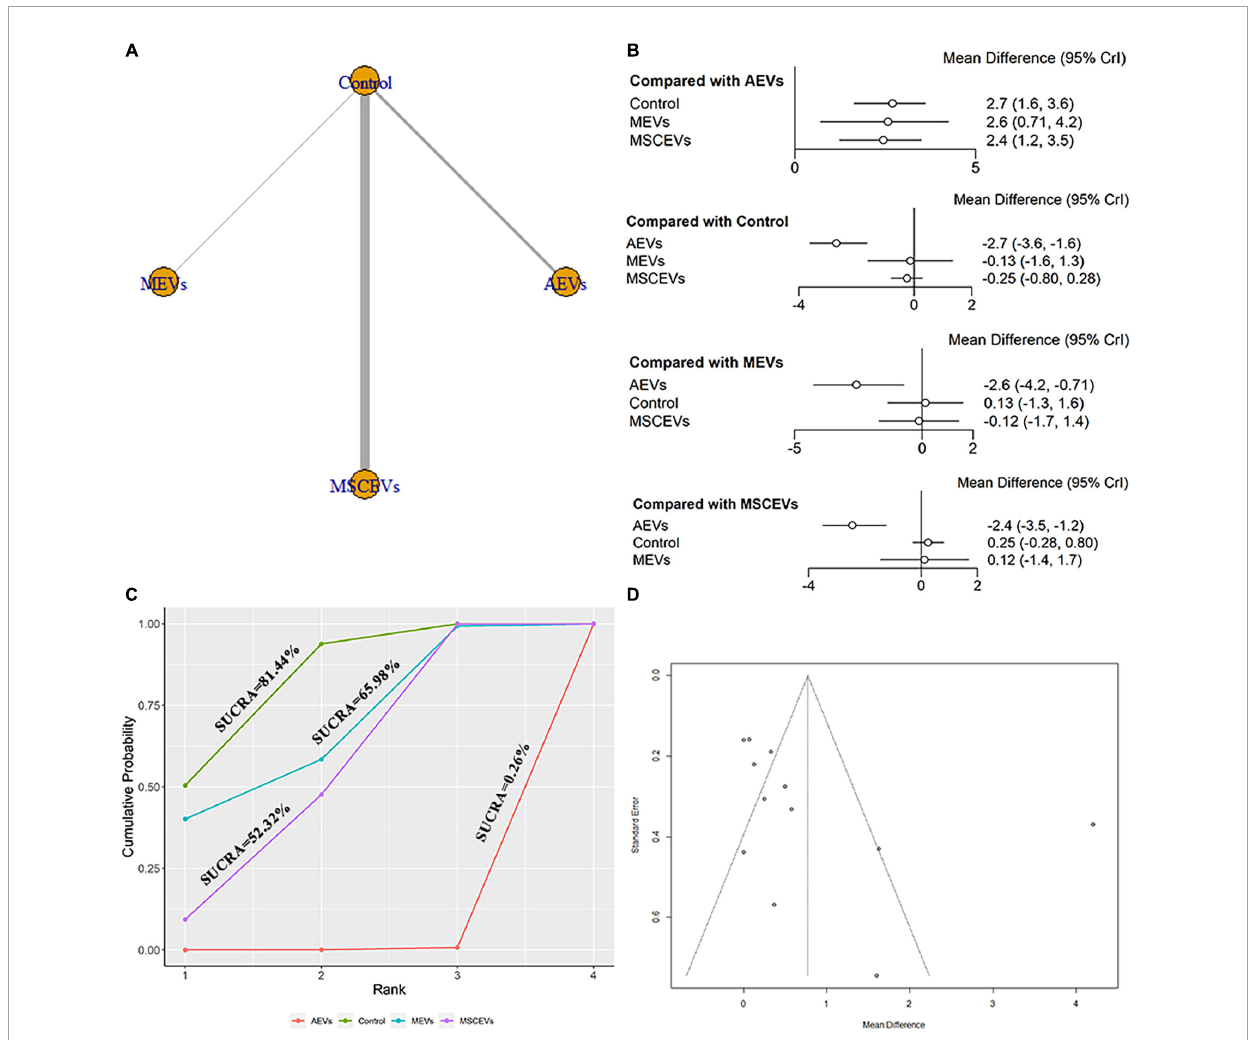
FIGURE2 Comparison of the efficacy of extracellular vesicles (EVs) from different cell sources in modified Neurological Severity Score (mNSS) at day 1 post-traumatic brain injury (TBI). (A) Network plot; (B) Forest plot; (C) Surface under the cumulative ranking curves (SUCRA); (D) Funnel plot. The dotted lines represent 95% confidence interval (95% CI). AEVs, astrocyte-derived extracellular vesicles; MEVs, microglia-derived extracellular vesicles; MSCEVs, mesenchymal stem cell-derived extracellular vesicles; NSCEVs, neural stem cell-derived extracellular